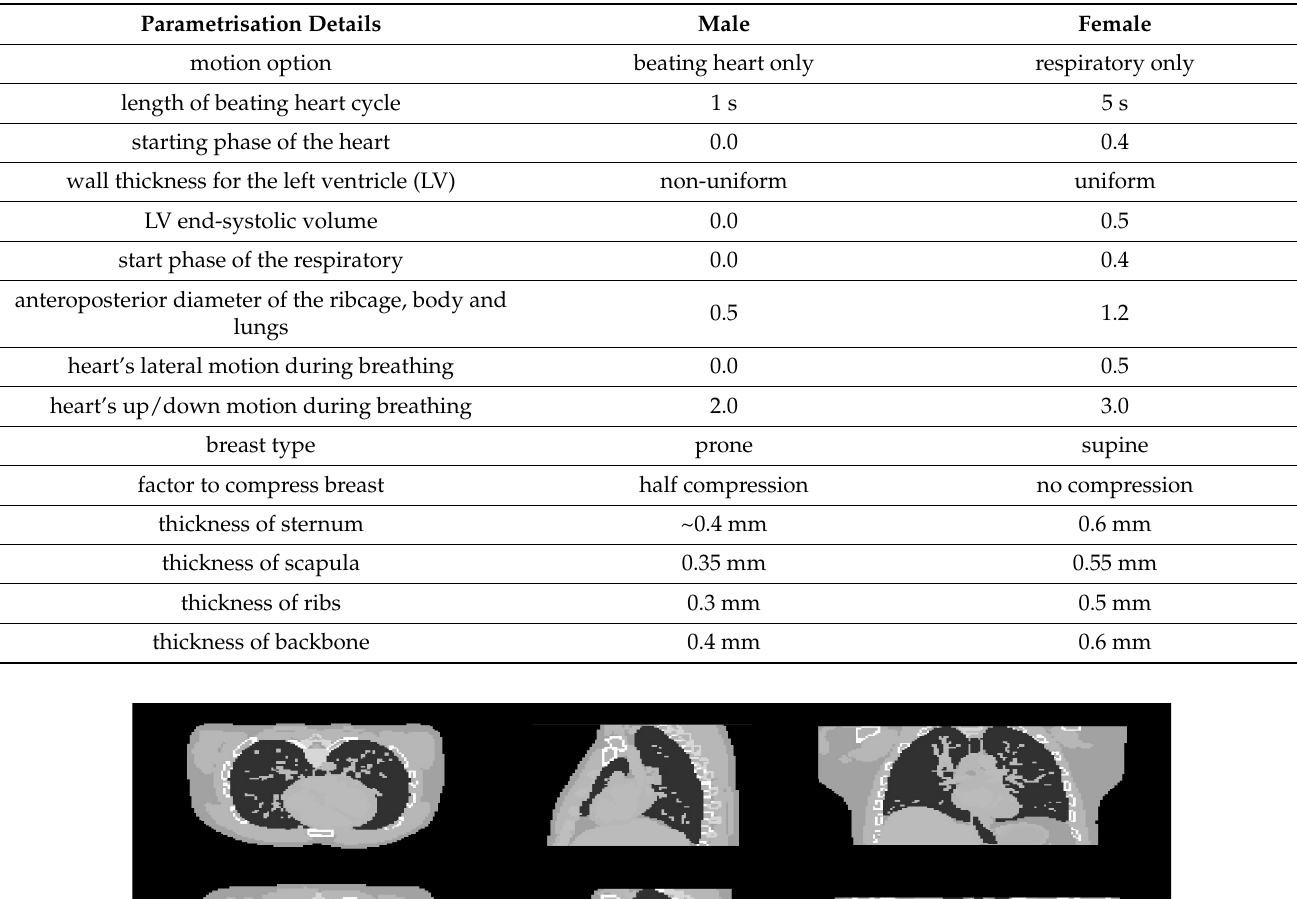
Table 4. The parametrisation details of the two phantoms [11].